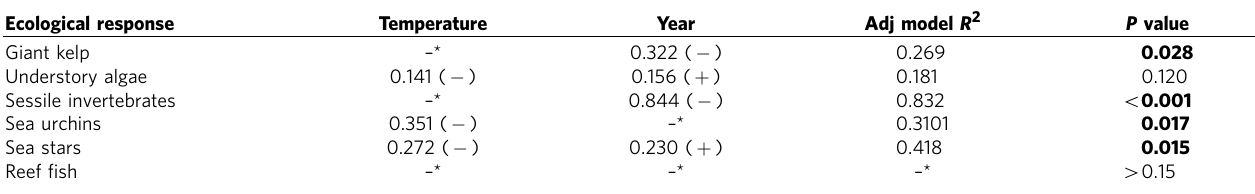
Results of stepwise multiple regression analyses showing the amount of variation in the summer biomass of different functional groups of kelp forest species (that is, ecological response variables) explained by year and anomalies in bottom temperature for the preceding 12 months. Numbers reported for the independent variables (temperature and year) are partial R 2 values; the direction of the